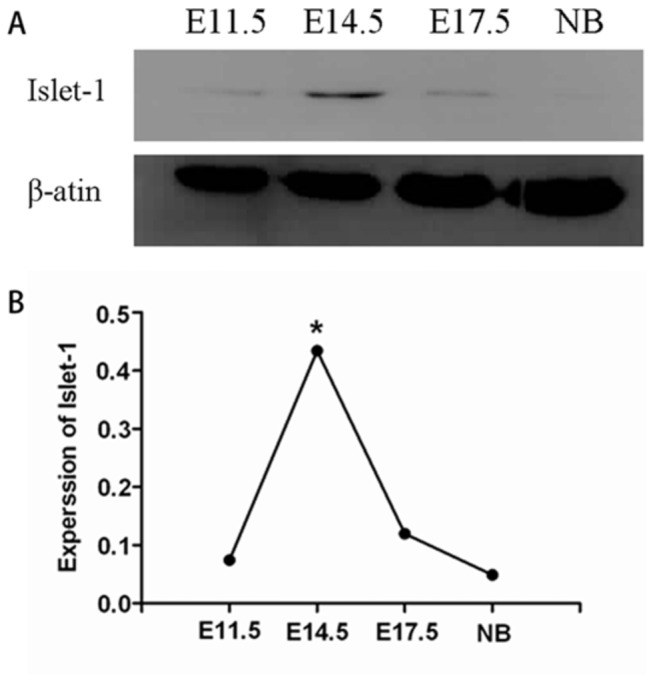
Expression of Islet-1 protein in mouse embryonic and neonatal hearts.A representative Western blotting showed that Islet-1 was dynamically expressed in the embryonic hearts. The expression of Islet-1 in mouse embryonic hearts was significantly higher on E14.5 than that on E11.5, E17.5, and neonatal mice. * p < 0.05 (n=3).